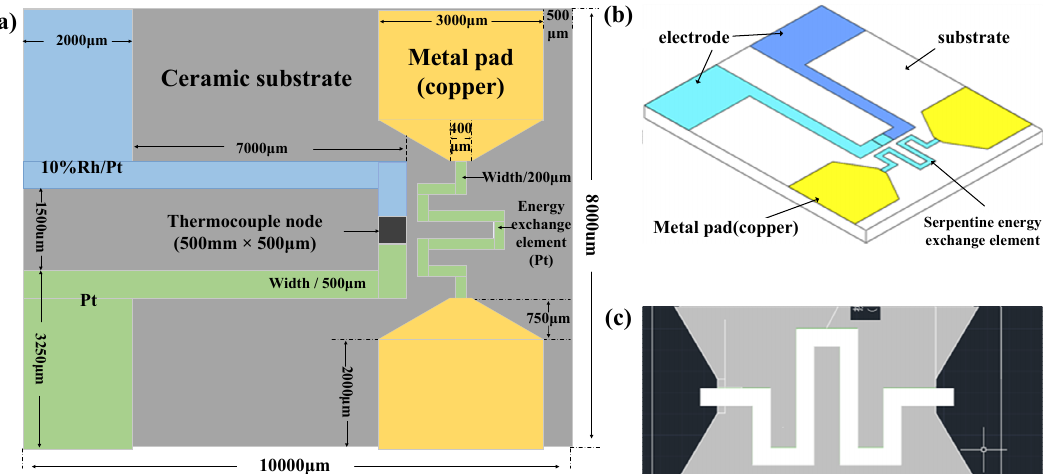
Figure 1. Structure diagram of Pt-Rh10/Pt thin-film thermocouple. Thin-film Thermocouple Structure Diagram: ( a ) Thin-film thermocouple plan structure diagram; ( b ) Thin-film thermocouple three-dimensional structure diagram; ( c ) Serpentine micro-energy exchange element structure diagram.